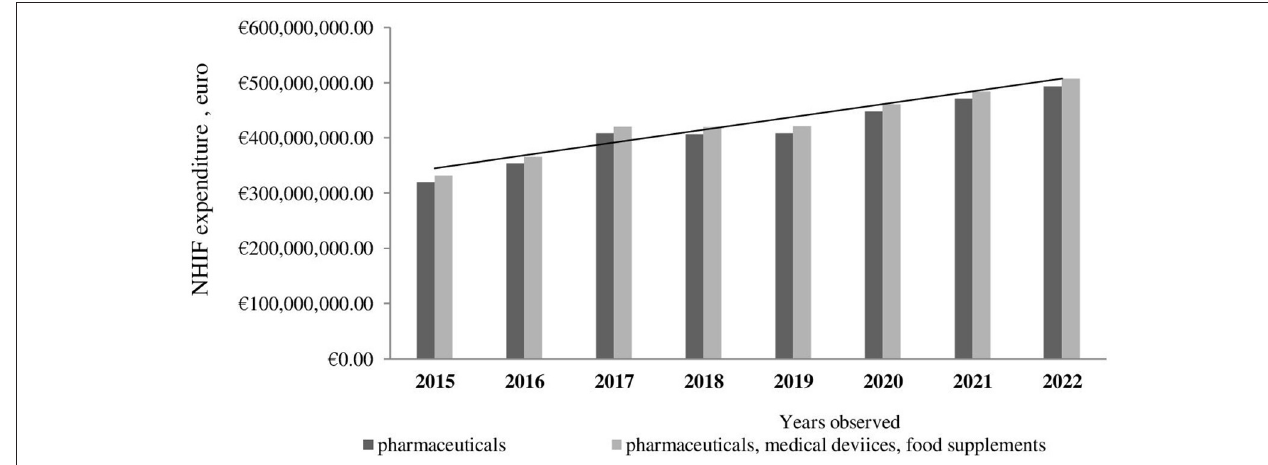
FIGURE 1 | Extrapolation of NHIF expenditures to 2022.